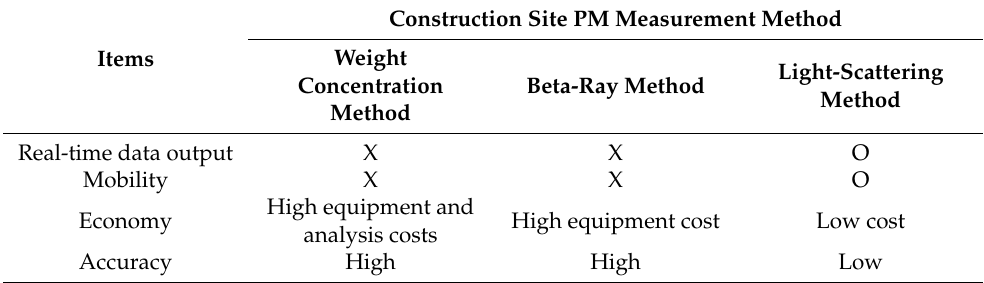
Table 1. Suitability of measurement method according to the characteristics of construction site.